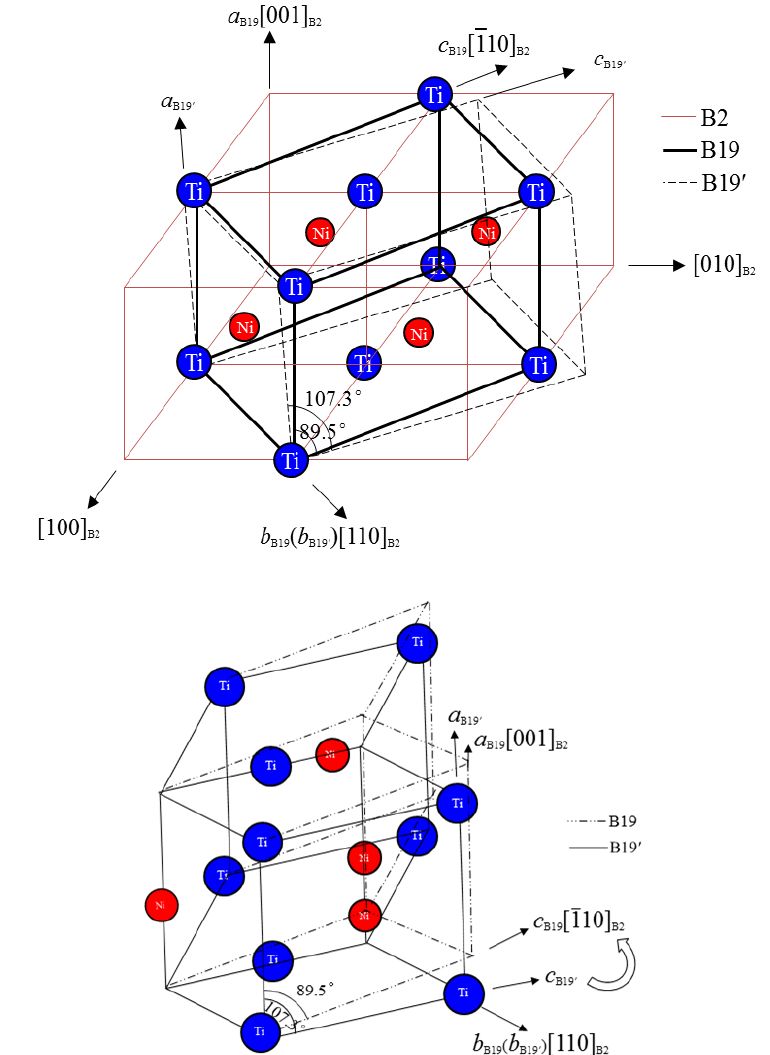
Figure 4. Schematic diagram showing the transition of martensite crystal structure from B19′ to B19 as a result of Cu addition in